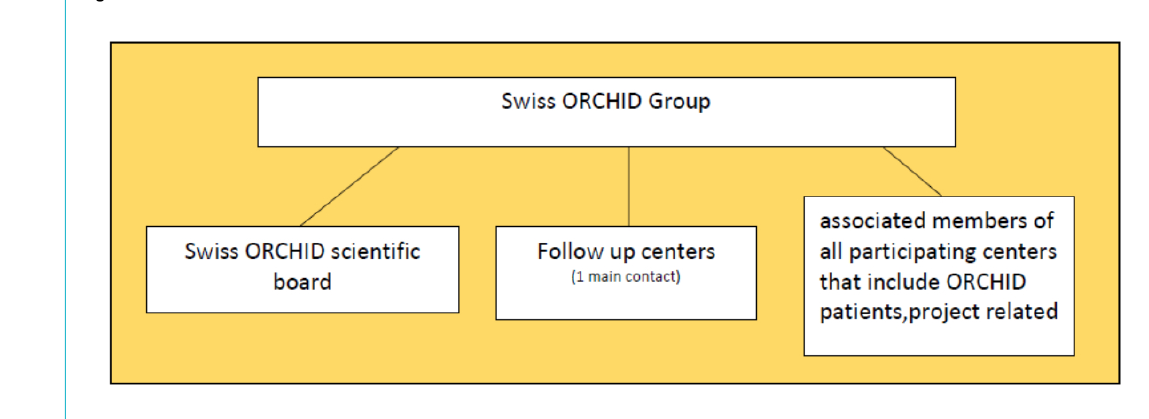
Figure 1: Swiss ORCHID